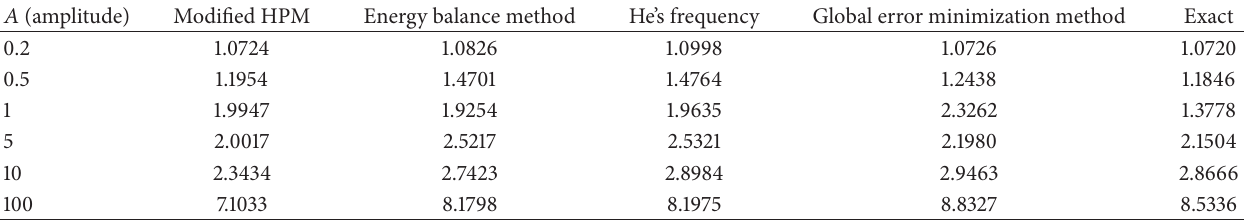
Table 1: Comparison of HPM, He’s frequency, energy balance method, global error method, and exact